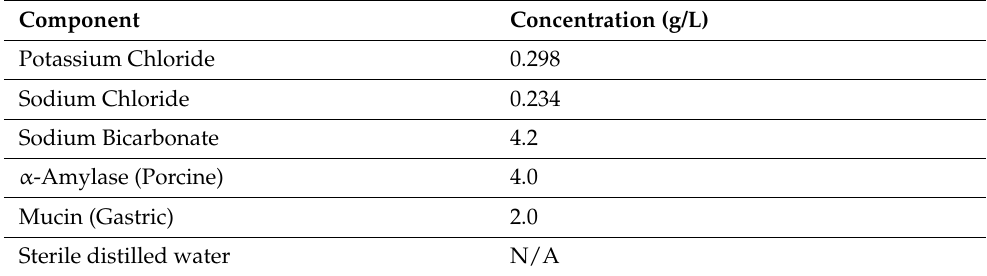
Table 1. Double strength Simulated Saliva recipe (used double strength stock to mix with equal amount of TSA broth and Phi6).